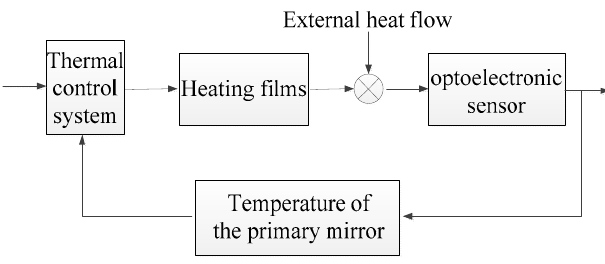
Figure 7. Feedback loop of the thermal control system.